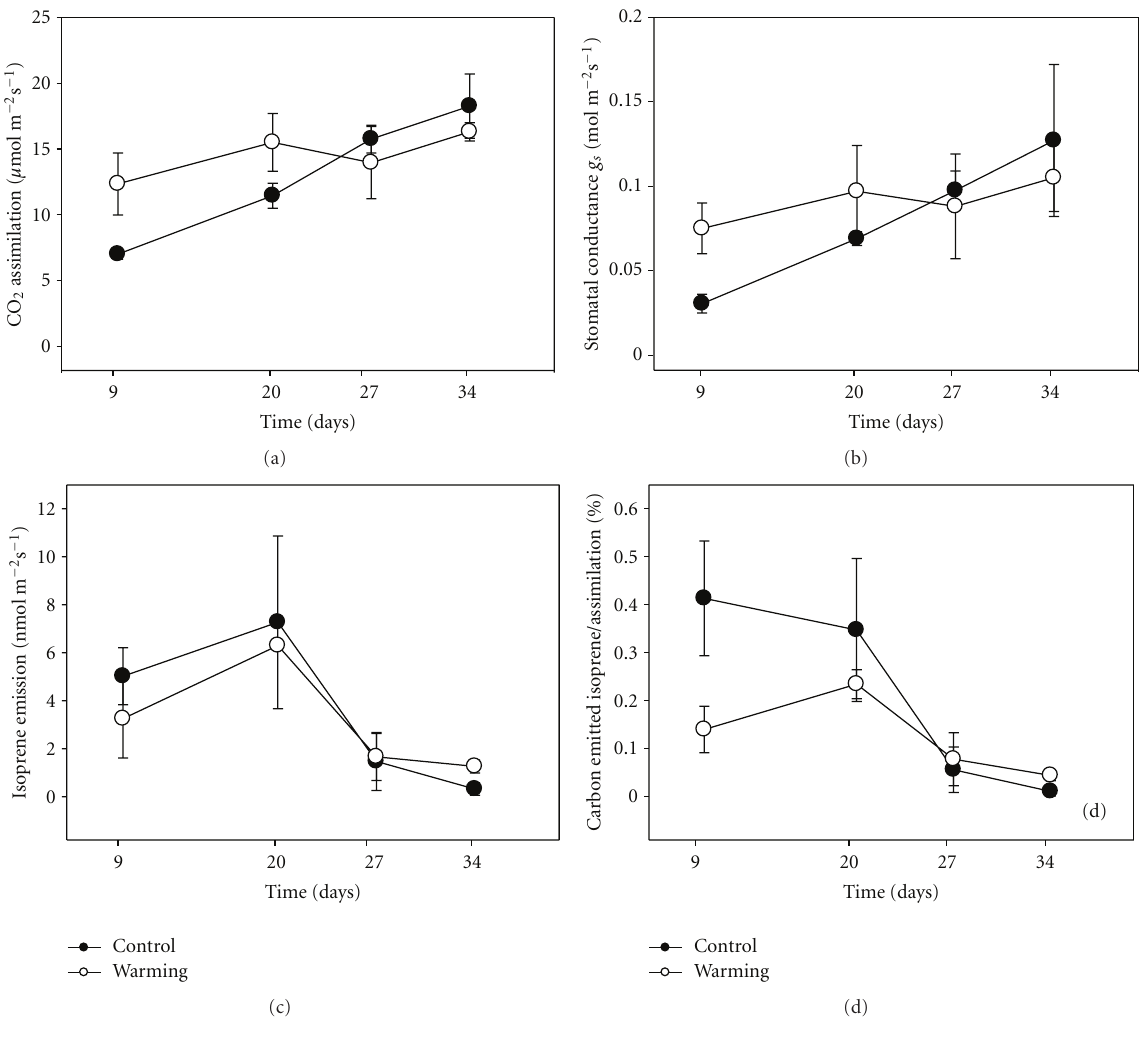
Figure 1: Time course of (a) CO 2 Assimilation ( μ molm − 2 s − 1 ), (b) Stomatal conductance (molm − 2 s − 1 ), (c) Isoprene emission (nmolm − 2 s − 1 ), (d) percentage of assimilated carbon lost as isoprene (%), ± S.E. for Phragmites australis grown in a hydroponic system with water at di ff erent temperatures at 9, 14, 21, and 27 days after start of treatment. Measurements started after 9 days from the beginning of the warming treatment, that is, as soon as the first mature leaves were